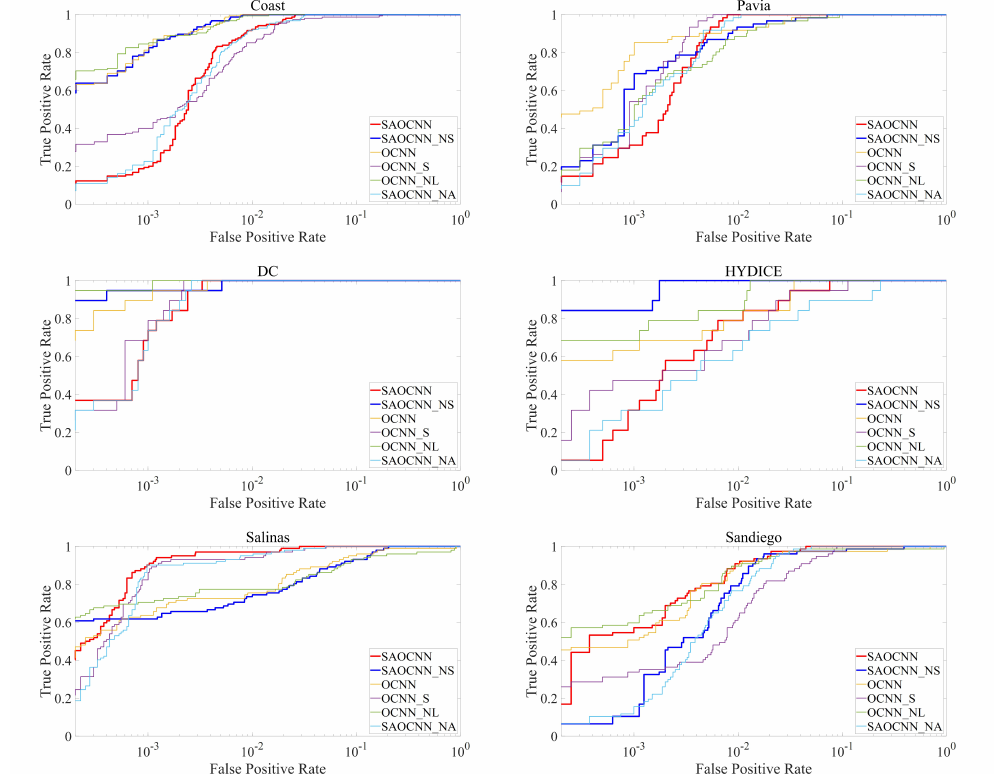
Figure 11. ROC of ( P d , P f ) for ablation